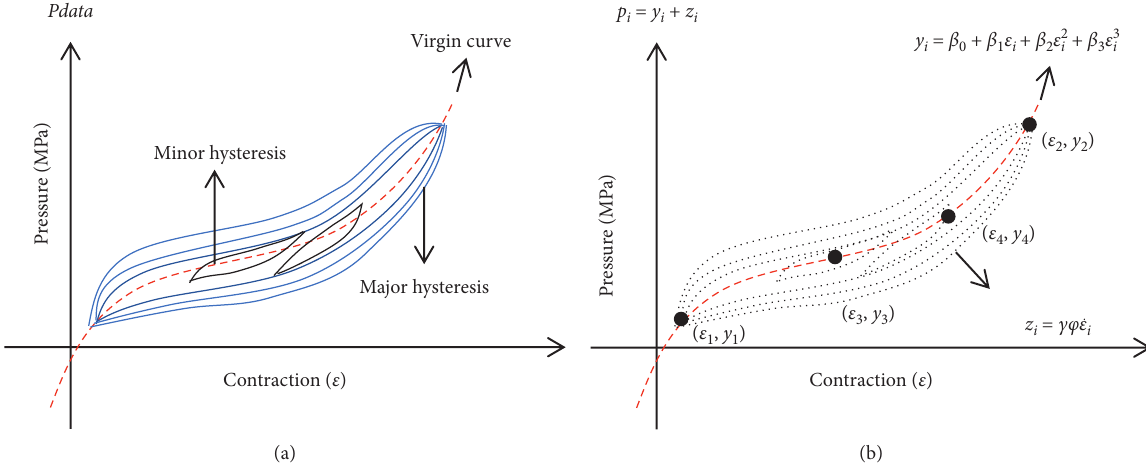
Figure 1: Hysteresis of PAM: (a) measured activation pressure and (b) activation pressure